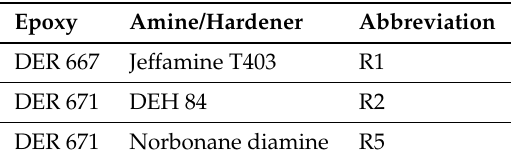
Table 2. Composition at the stoichiometry of the systems